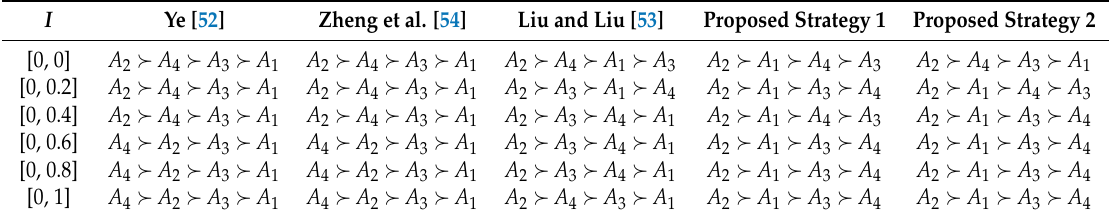
Table 3. Comparison of ranking preference order with variation of “ I ” on NNs for different